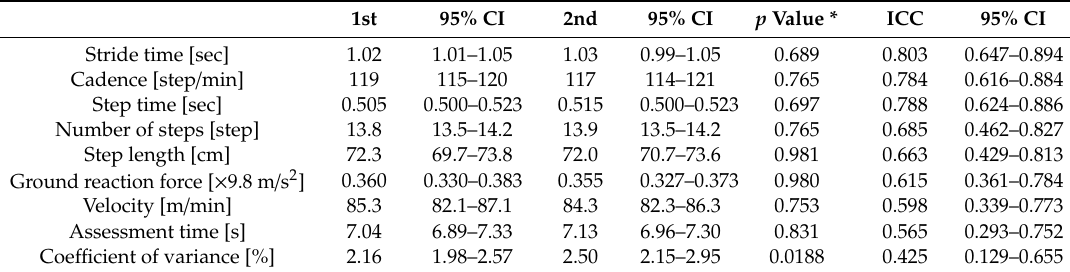
Table 1. Median and intra-correlation coefficient for each parameter at and between first and second 10-m walks in healthy subjects ( n = 36).